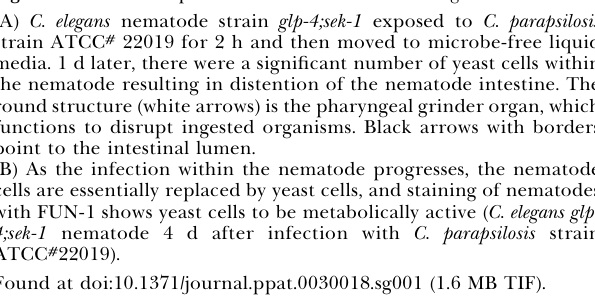
Figure S1. Candida Species Accumulate in the C. elegans Intestine (A) C. elegans nematode strain glp-4;sek-1 exposed to C. parapsilosis strain ATCC# 22019 for 2 h and then moved to microbe-free liquid media. 1 d later, there were a significant number of yeast cells within the nematode resulting in distention of the nematode intestine. The round structure (white arrows) is the pharyngeal grinder organ, which functions to disrupt ingested organisms. Black arrows with borders point to the intestinal lumen. (B) As the infection within the nematode progresses, the nematode cells are essentially replaced by yeast cells, and staining of nematodes with FUN-1 shows yeast cells to be metabolically active ( C. elegans glp- 4;sek-1 nematode 4 d after infection with C. parapsilosis strain ATCC#22019). Found at doi:10.1371/journal.ppat.0030018.sg001 (1.6 MB TIF). Figure S2. In Vitro Efficacy of CAPE, Enoxacin, and Lapachol Biofilm on the Surfaces of Wells of Microtiter Plates When evaluated using the XTT reduction assay, CAPE and lapachol inhibited the formation of biofilm (A), while all three compounds had an affect in pre-formed biofilm (B). Found at doi:10.1371/journal.ppat.0030018.sg002 (58 KB TIF). Table S1. Compounds Identified through a Pilot Screen in C. elegans Found at doi:10.1371/journal.ppat.0030018.st001 (349 KB